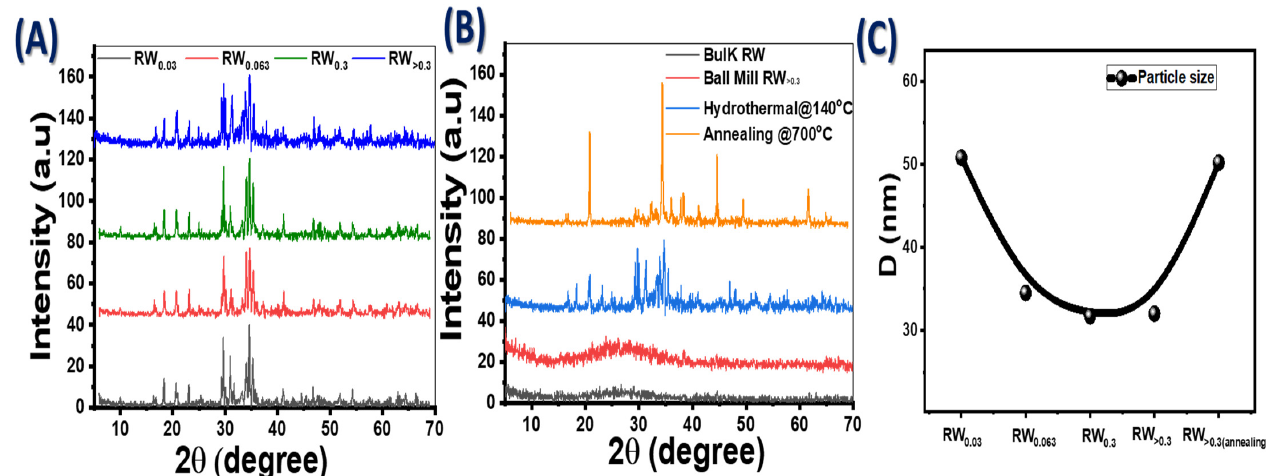
Figure 1. ( A ) Standard XRD patterns for fabricated nanostructure RW at different particle sizes, ( B ) XRD patterns of bulk RW and RW >0.3 after ball milling, hydrothermal technique and annealing; and ( C ) particle size for all RW samples.